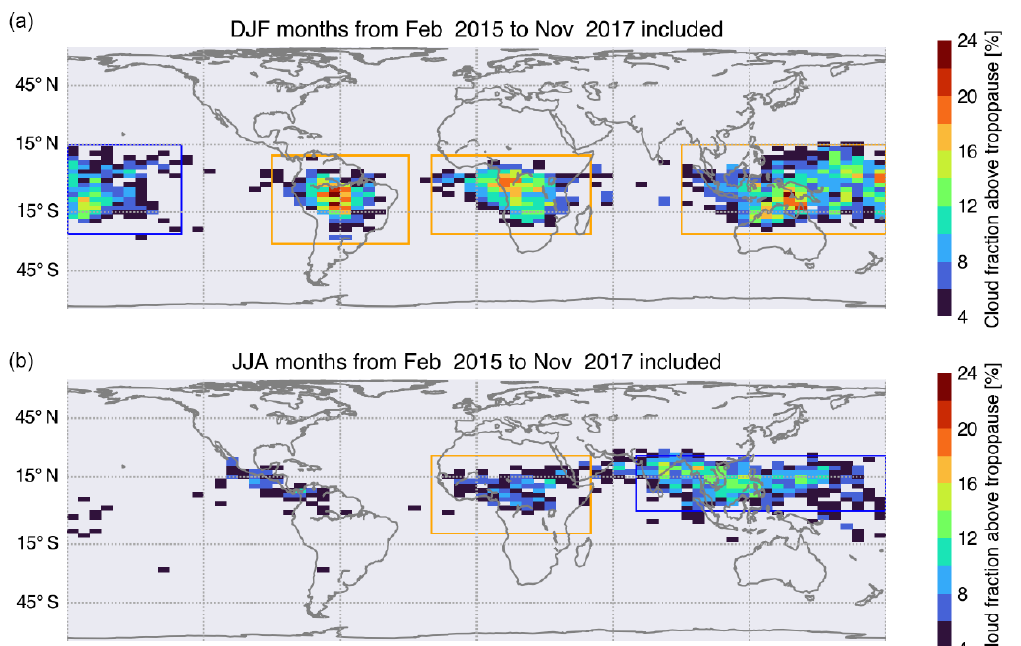
Figure 1. Tropical low-stratosphere cloud fraction for (a) DJF and (b) JJA. CATS measurements between February 2015 and November 2017, calculated by considering all profiles in 2 ◦ × 5 ◦ latitude–longitude boxes. The rectangles are the regions in which cloud detections are aggregated in the rest of the study. In DJF, from left to right: the West Pacific (25 ◦ S–15 ◦ N, 180–130 ◦ W), South America (30 ◦ S–10 ◦ N, 90–30 ◦ W), Equatorial Africa (25 ◦ S–10 ◦ N, 20 ◦ W–50 ◦ E) and the South Warm Pool (25 ◦ S–15 ◦ N, 90–180 ◦ E). In JJA, from left to right: here. In the rest of the study, we considered profiles over the ocean in blue boxes and profiles over land in orange boxes.